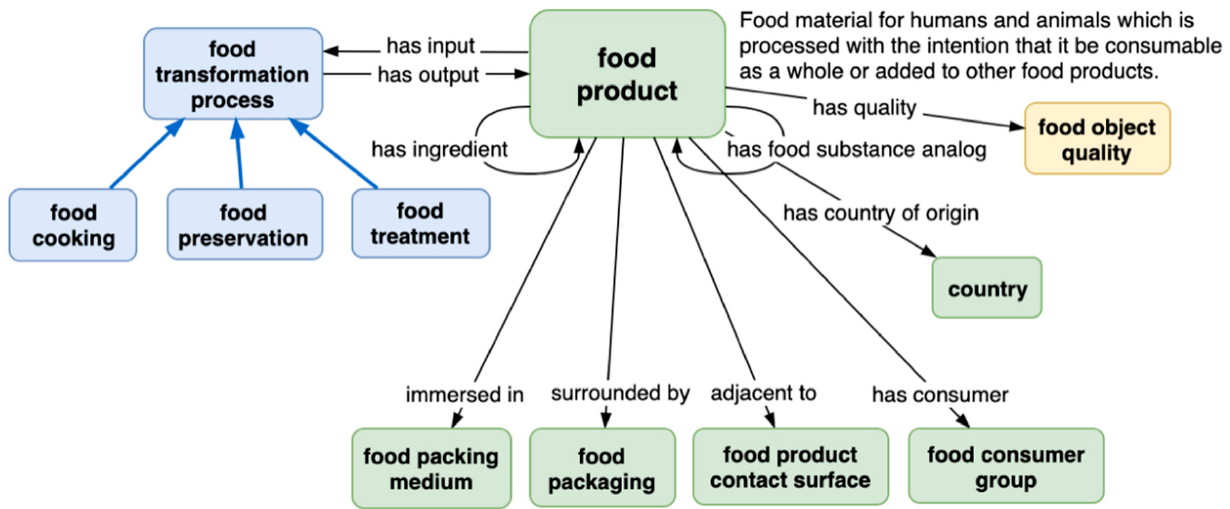
Figure 1. Some facets provided in FoodOn and their relations to a certain food product, of which primary objective is to provide the vocabulary to describe a given food. Reprinted with permission from ref. [26,27]. 2017. Roger A Smith (cc-by- sa/2.0).